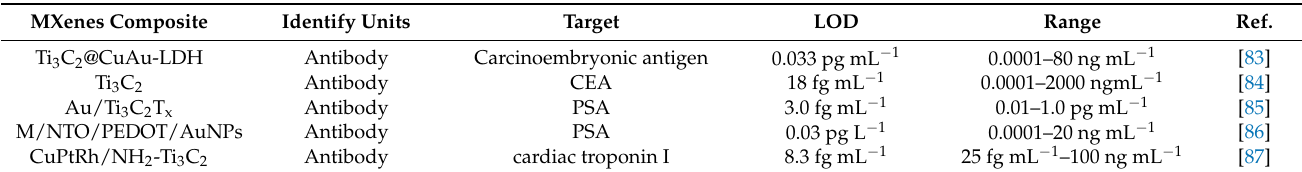
Table 3. Immunoelectrochemical biosensors identify units, target, and analytical parameters. MXenes Composite